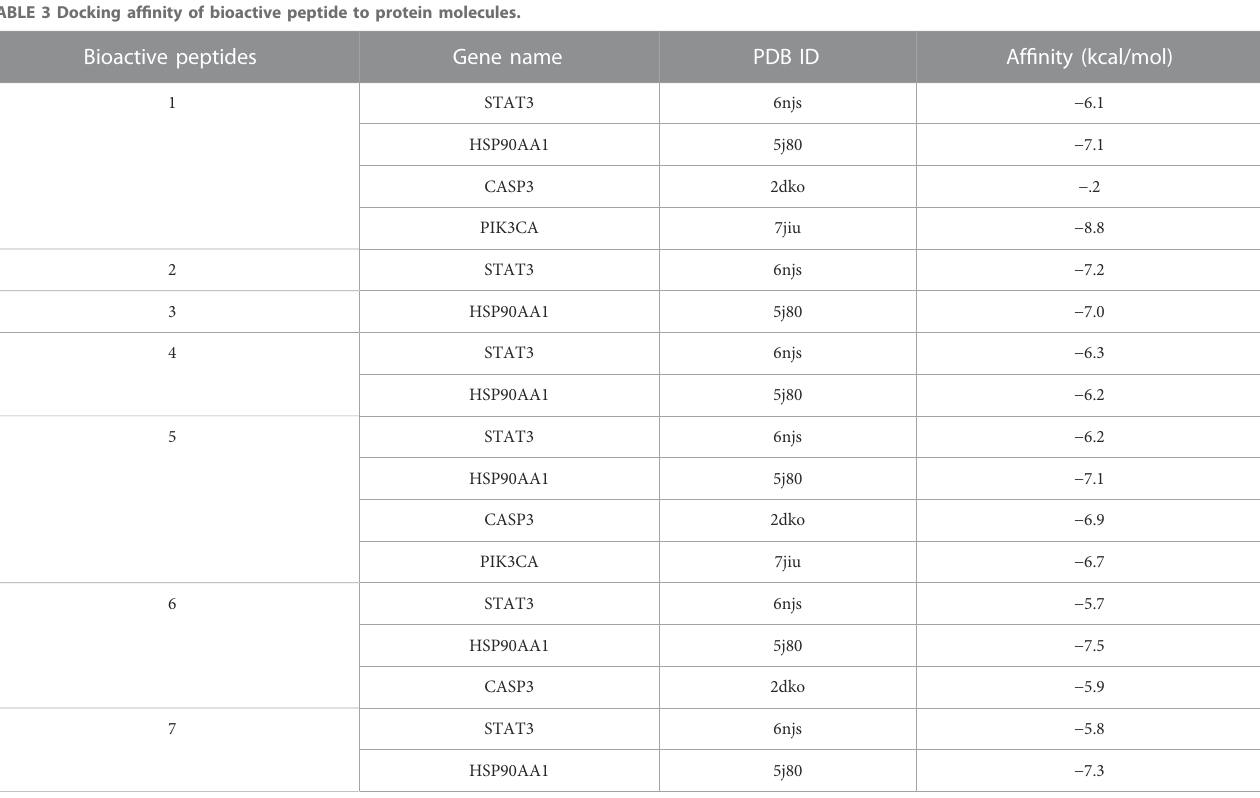
TABLE 3 Docking af fi nity of bioactive peptide to protein